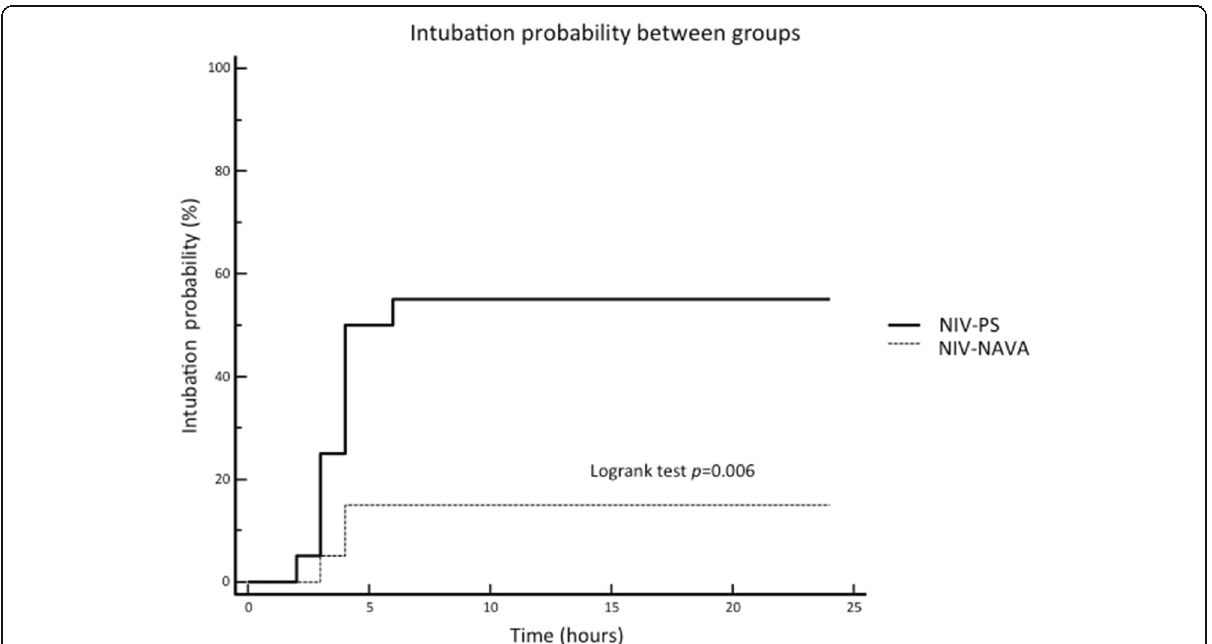
Fig. 1 Kaplan-Meier plot of intubation probability between groups in the first 24 h. NIV-PS, noninvasive pressure support; NIV-NAVA noninvasive neurally adjusted ventilatory